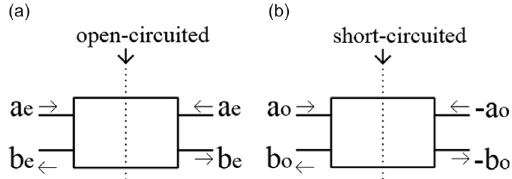
Figure 4. Two port network (a) even-mode excitation (b) odd-mode excitation.